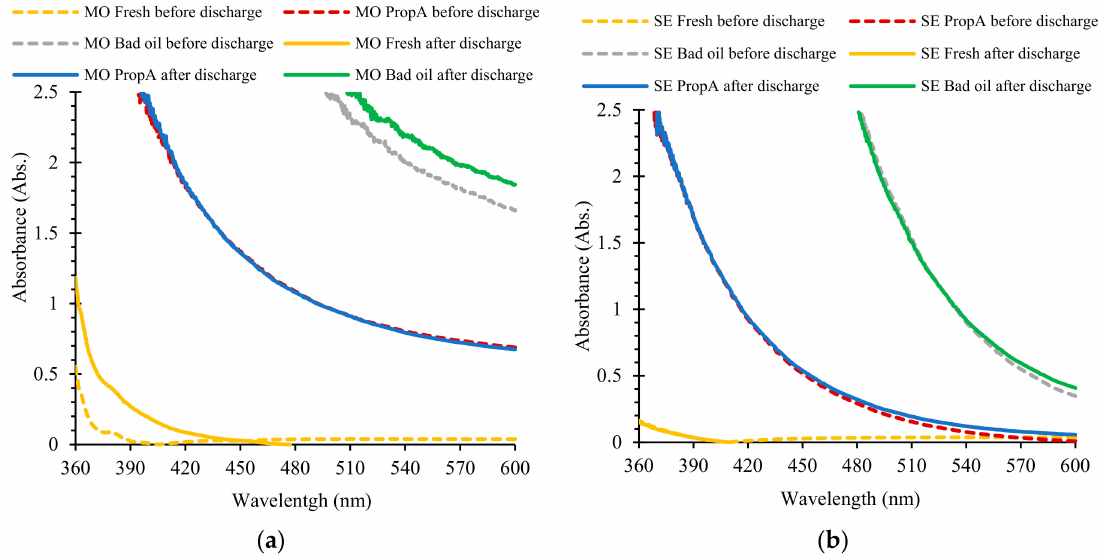
Figure 2. Ultraviolet (UV) spectral curves of insulating liquids before and after discharges at di ff erent aging conditions: ( a ) for mineral oil; ( b ) for synthetic